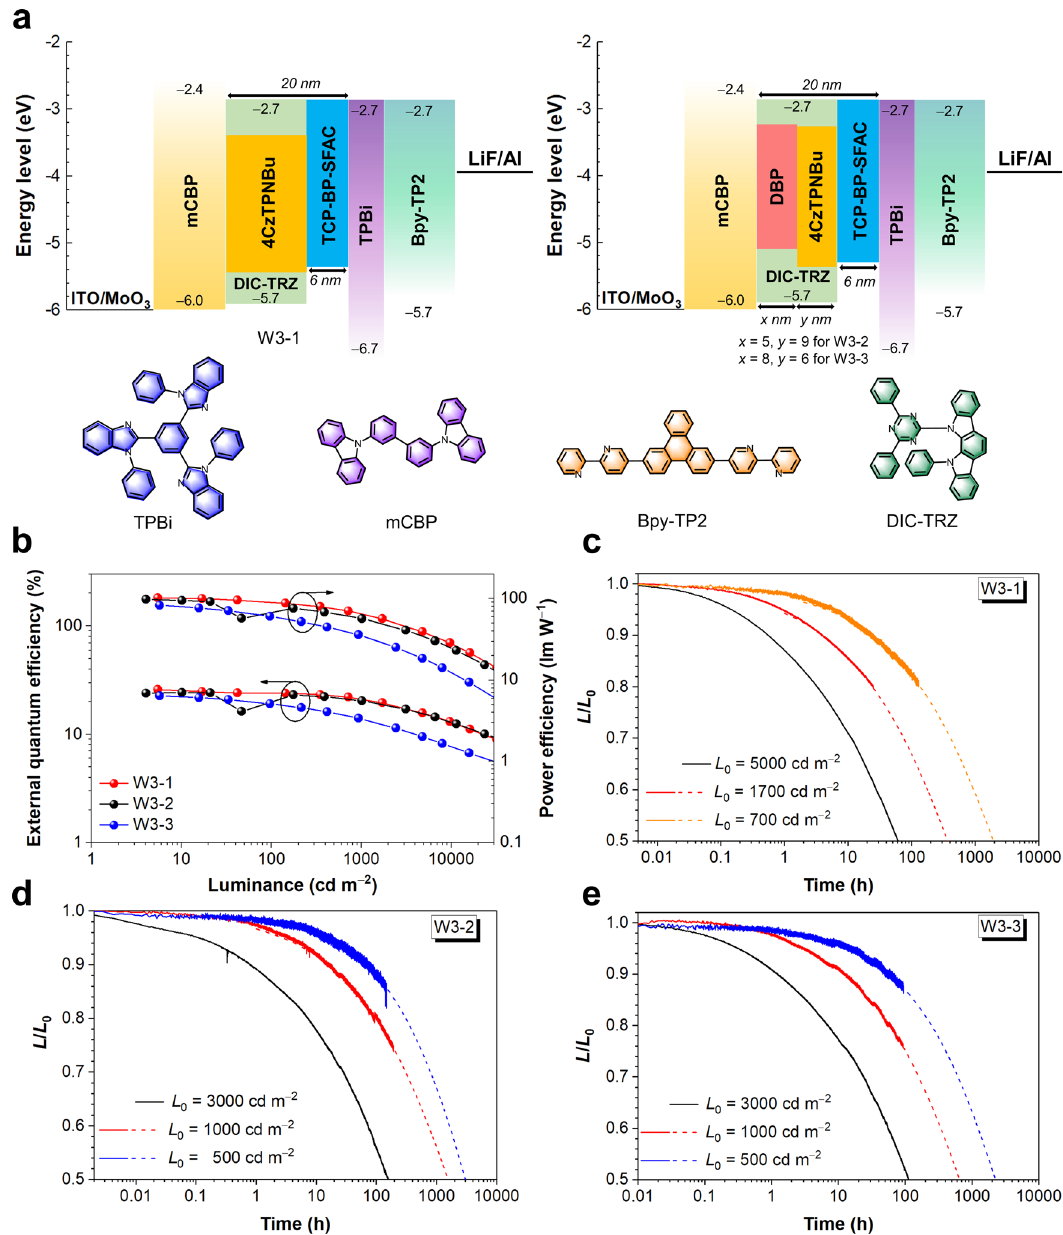
Fig. 7 | Device data and EL performance of the devices with improved opera- tional lifetimes. a Device con fi gurations of W3-1 (left), and W3-2 and W3-3 (right) with molecular structures of additional functional materials. b External quantum ef fi ciency-luminance-power ef fi ciency curves of devices W3-1 – W3-3.